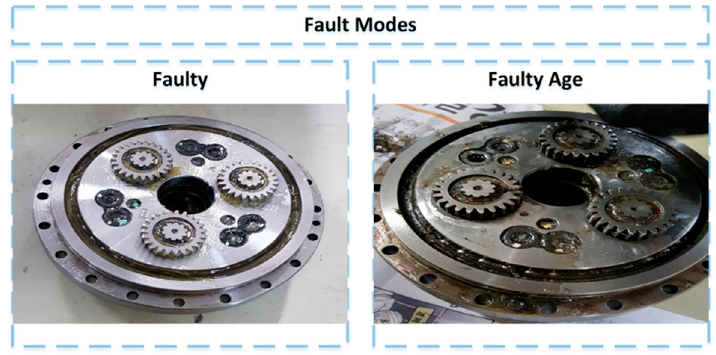
Figure 6. ( a ) Location of the fault, and ( b ) comprehensive logical view.